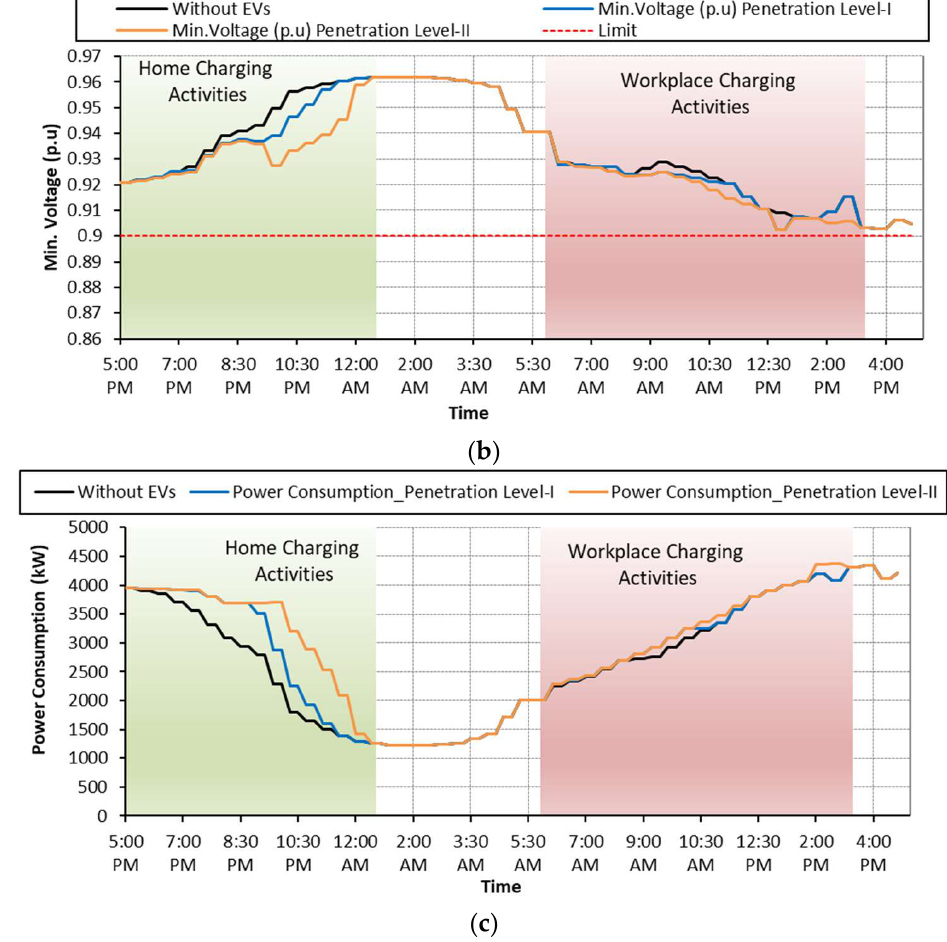
Figure 10. Case B: ( a ) Network power loss; ( b ) voltage deviation; ( c ) network power consumption .